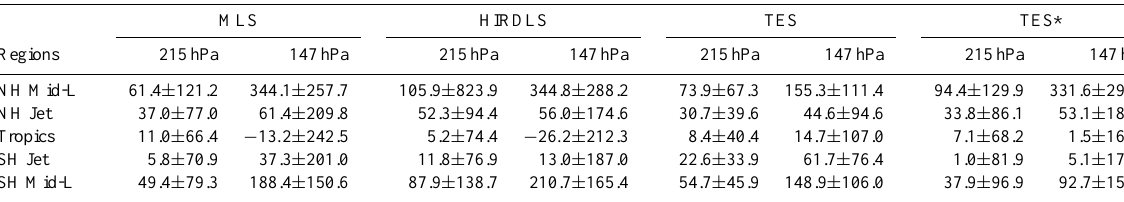
Table 3. Same as Table 2 for January 2006 a